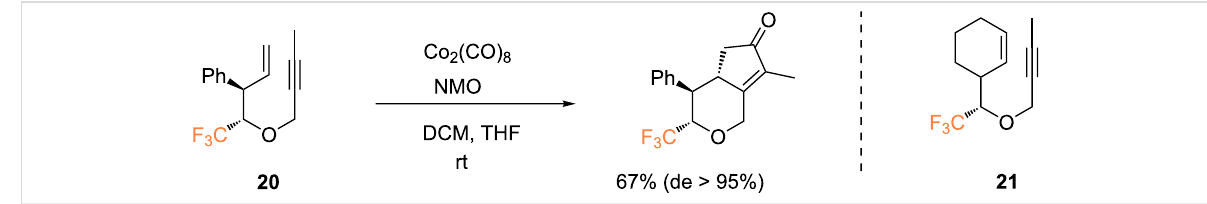
Scheme 9: Intramolecular PKR of 1,7-enynes reported by the group of Billard [48].